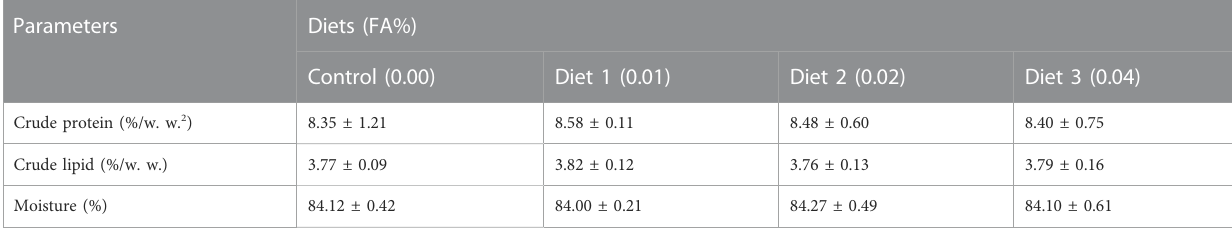
TABLE 4 Effects of supplemental fulvic acid on body composition of large yellow croaker larvae (Means ± S.E.M., n = 3) 1 .